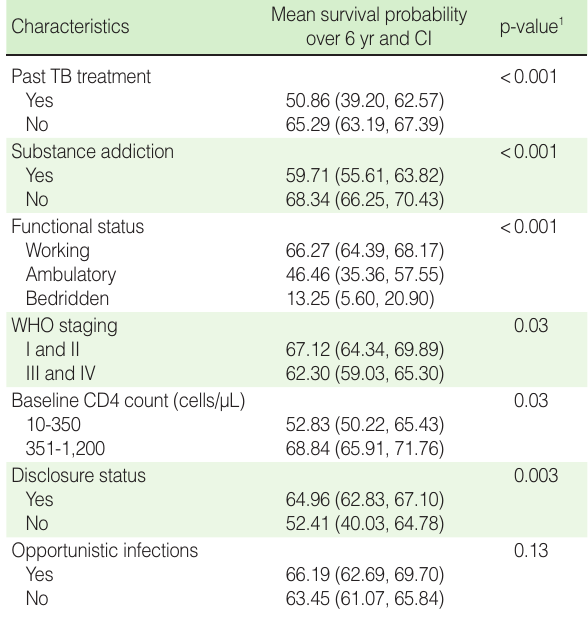
Table 3. Baseline characteristics and probability of survival during 6-year of follow-up (Kaplan-Meier method) of HIV patients receiving ART, Jinka Hospital, South Omo, Ethiopia in 2016 (n=350) Mean survival probability Characteristics over 6 yr and